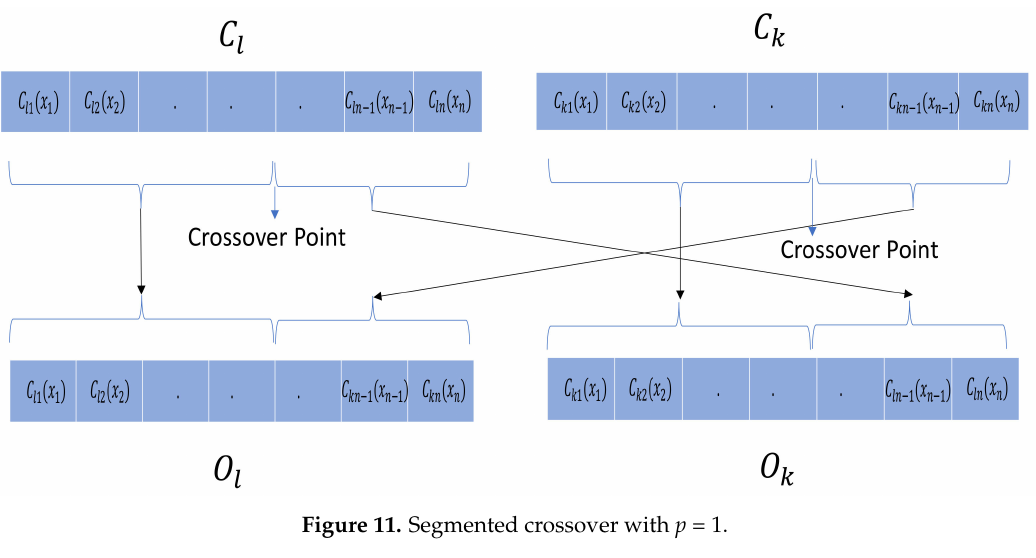
Figure 12. Example of the structural uniform crossover, mirroring ¬ O r